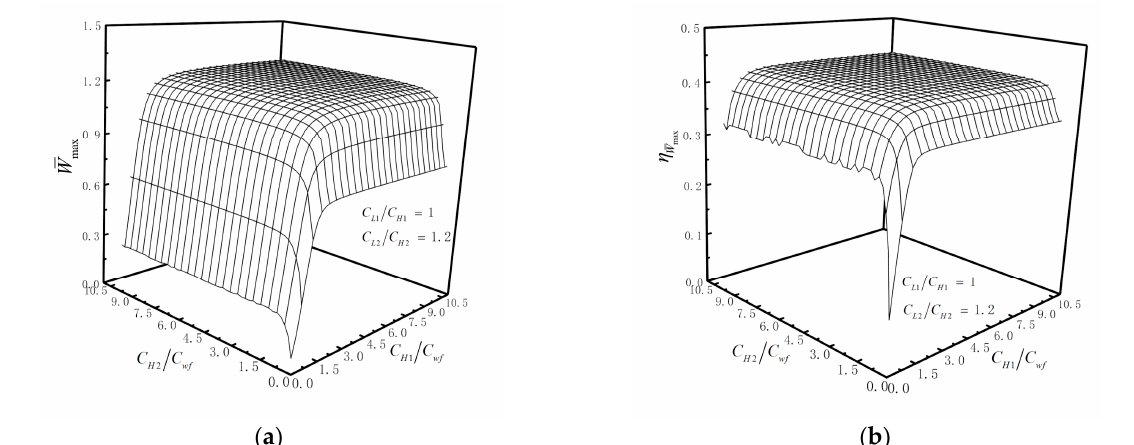
W versus C C and C ; ( b ) relationships of Figure 9. ( a ) Relationships of Figure 9. ( a ) Relationships of W max versus C H 1 / C wf and C H 2 / C wf ; ( b ) relationships of η max wf C H 1 / C wf and C H 2 / C wf and C .